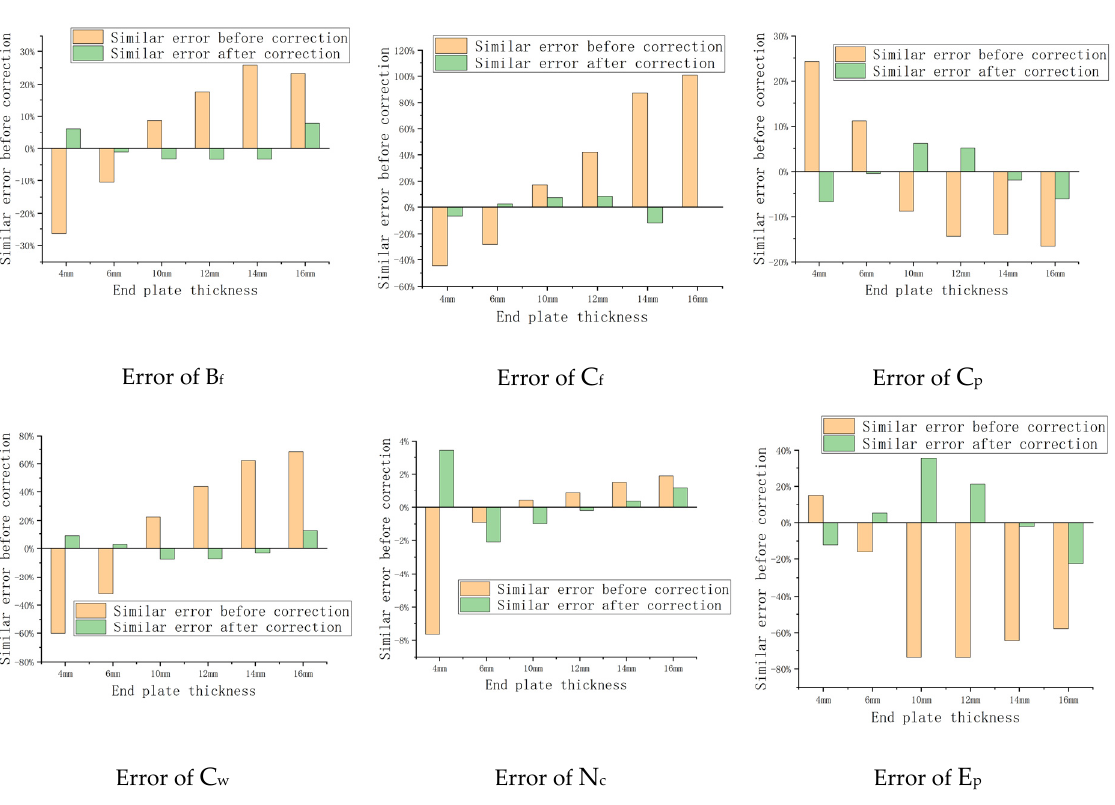
Figure 31. Linear regression-corrected value.